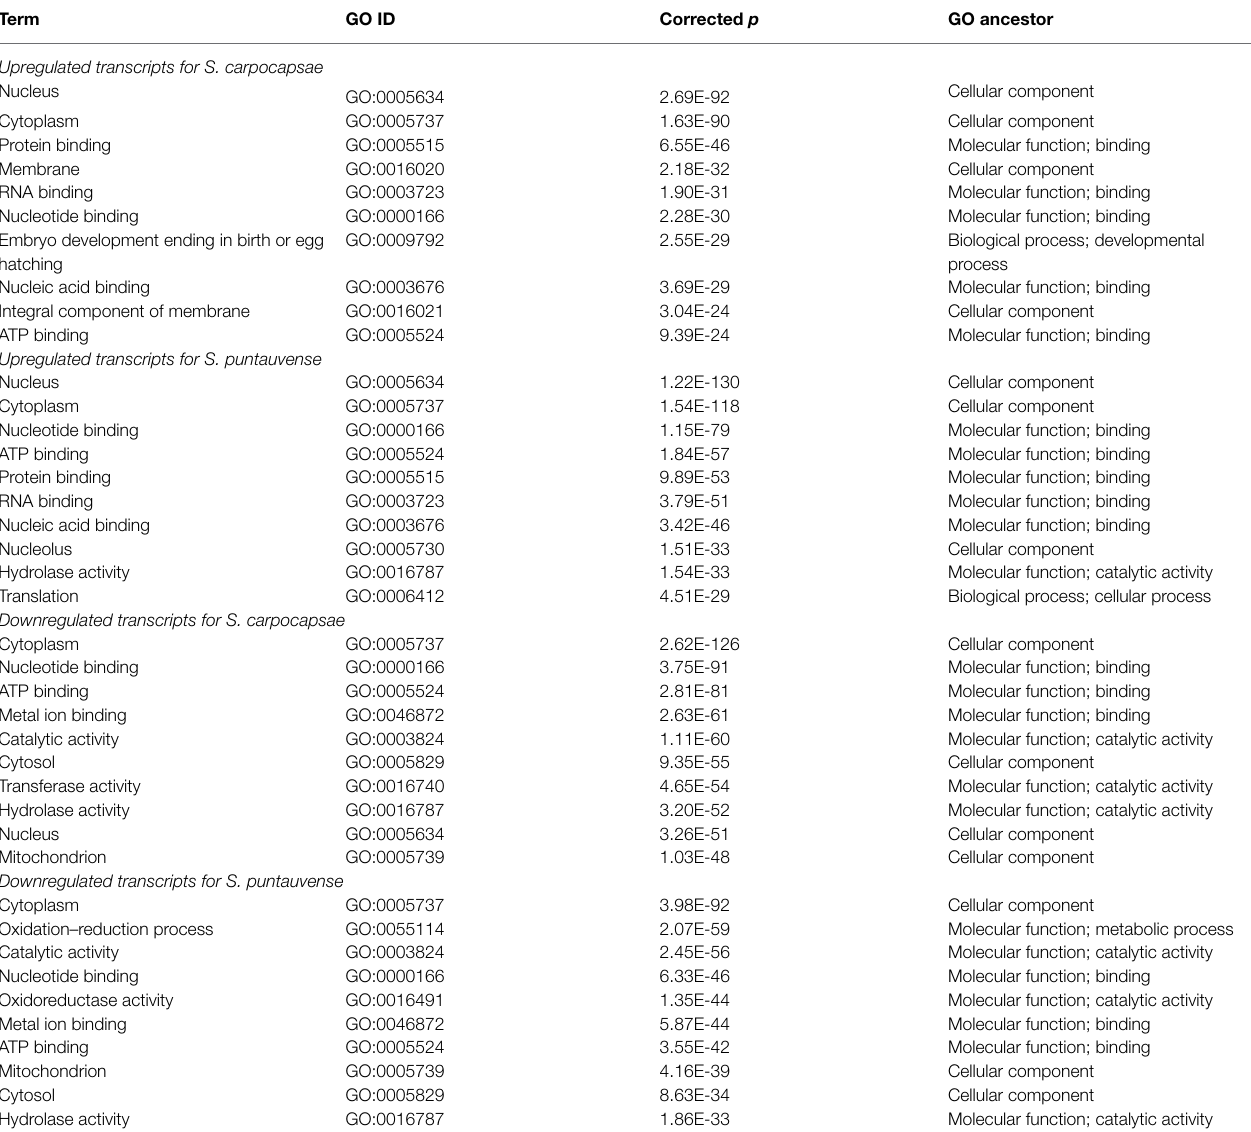
TABLE 2 | Top 10 enriched gene ontology (GO) terms of in vivo and in vitro aposymbiotic S. carpocapsae and S. puntauvense IJs. Term GO ID Corrected p GO ancestor Upregulated transcripts for S. carpocapsae